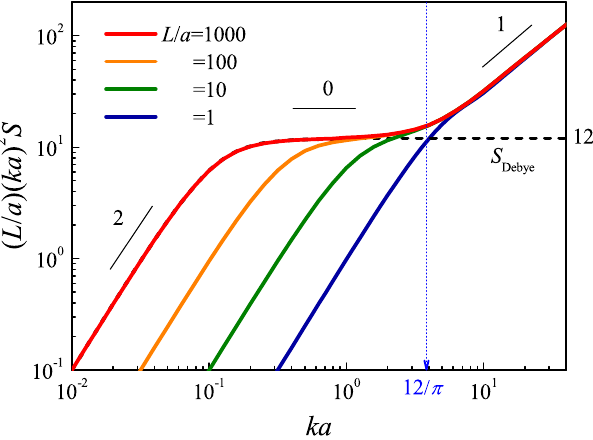
Figure 1. Structure factor of the worm-like chain (WLC) for various L / a in a double-logarithmic Kratky plot. Black solid lines with slopes of 2, 0 and 1 indicate the scaling behavior of the structure factor in different wavenumber regions. The dashed line is the S Debye , and dots indicate the crossover region between random walk behavior in the mesoscopic scale and the linear connection behavior in the microscopic